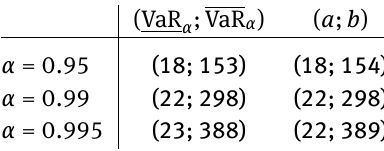
Table 5.2: VaR bounds in subgroup model with independence copula between subgroups.